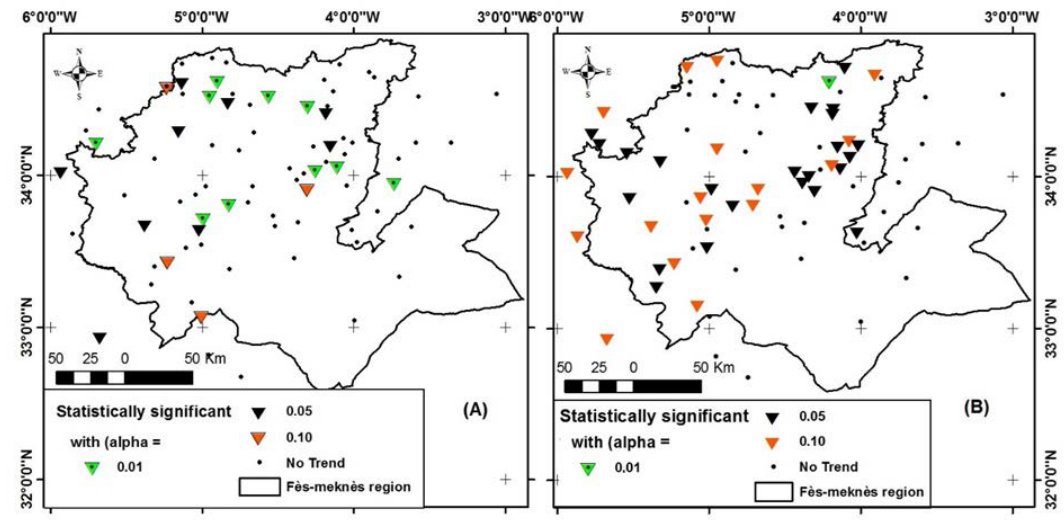
Figure 13. Spatial distribution of significant precipitation trends before ( A ) and after homogenization ( B